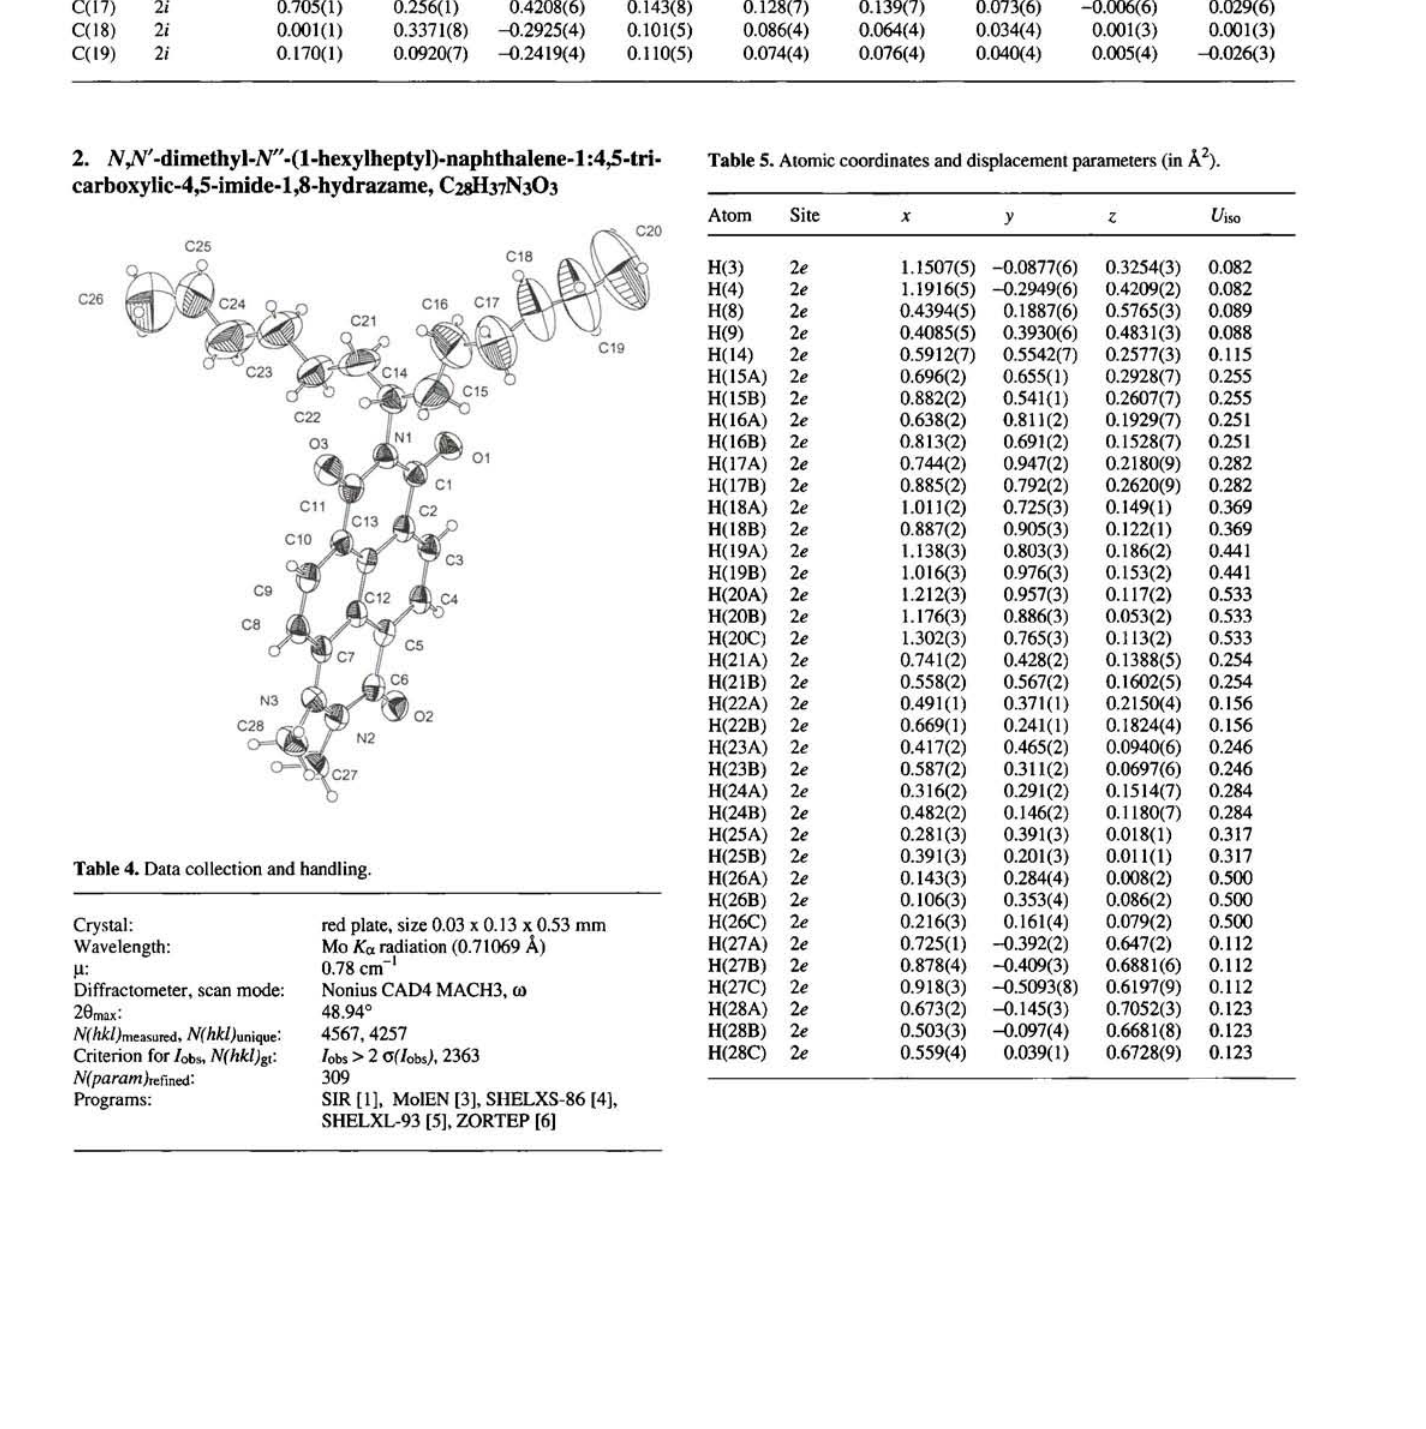
Table 5. Atomic coordinates and displacement parameters (in À 2 ).